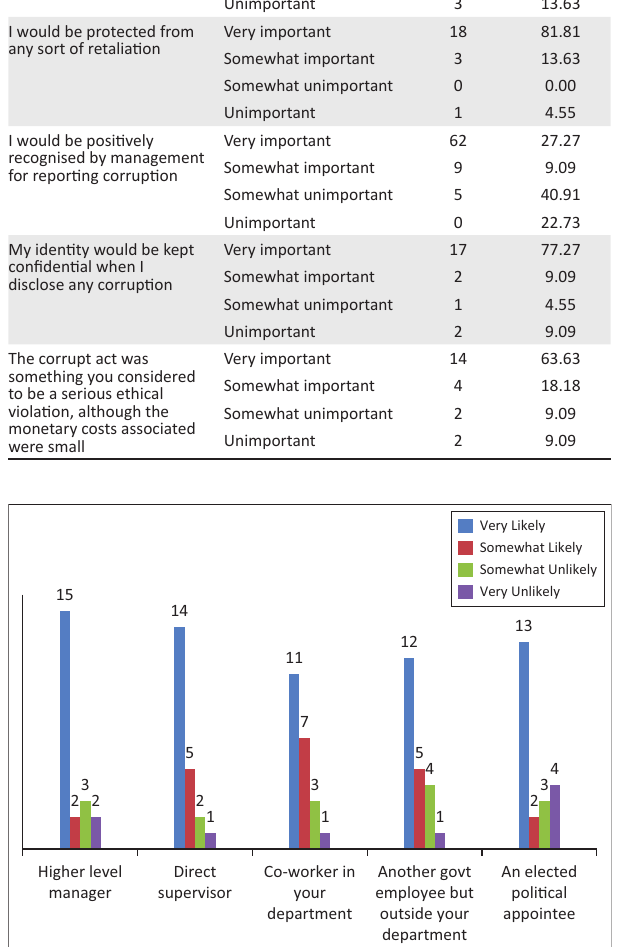
FIGURE 1: Likelihood of whistle-blowing.